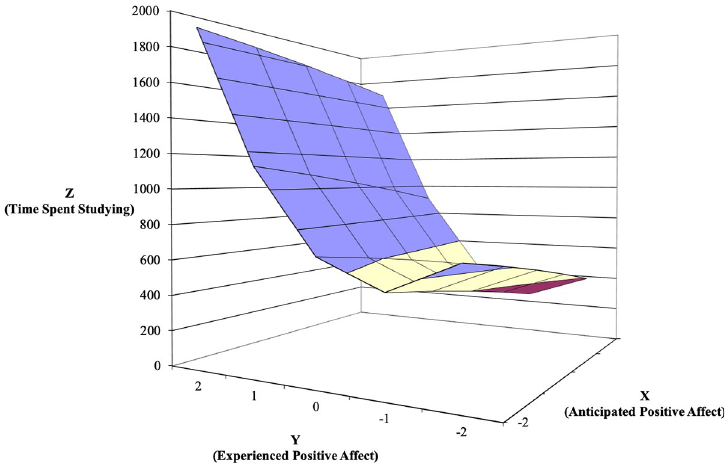
Fig 6. Response surface area wherein time spent studying is predicted by anticipated—experienced positive affect discrepancy (Study 2).